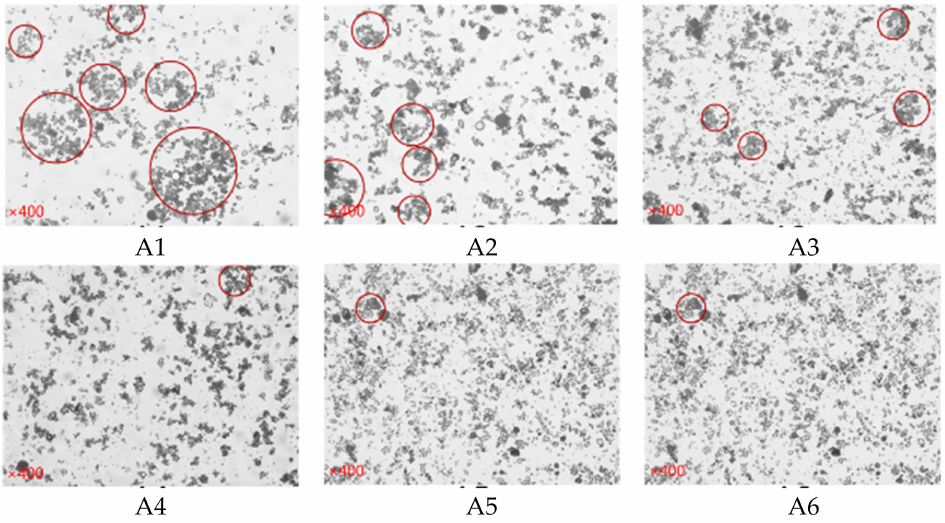
Figure 16. Microstructure of the cement paste containing